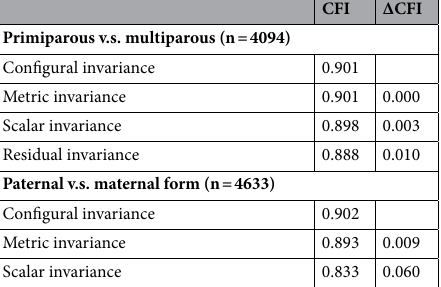
Table 4. Measurement invariance between primipara and multipara groups, and between the paternal and maternal PBI forms.